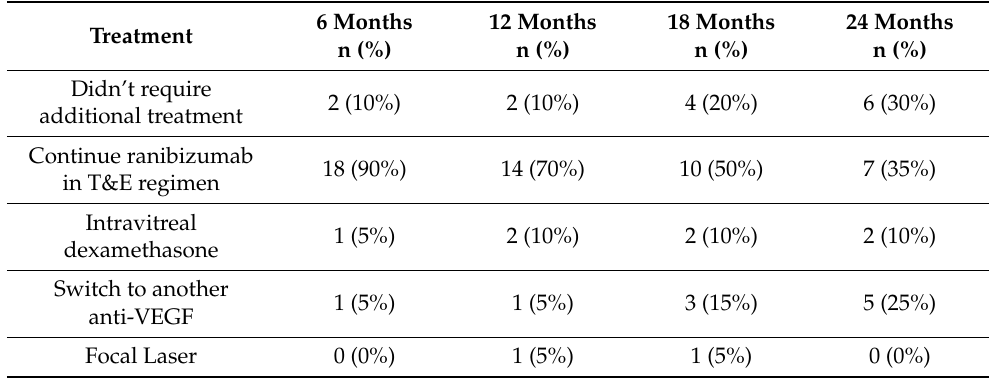
Table 1. Treatment received in each